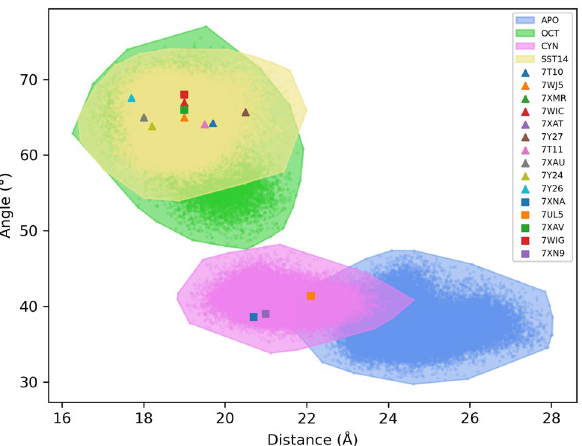
Figure 3. Scatter plot separating active from inactive conformations in SSTR2. The yellow, green, magenta and blue dots refer to each frame of the SSTR2-SST14, SSTR2-OCT, SSTR2-CYN and SSTR2 apo trajectories, respectively. The areas around dots represent the frame extension. The triangles and squares represent the experimental structures of SSTR2 (list of all experimental structures in Table